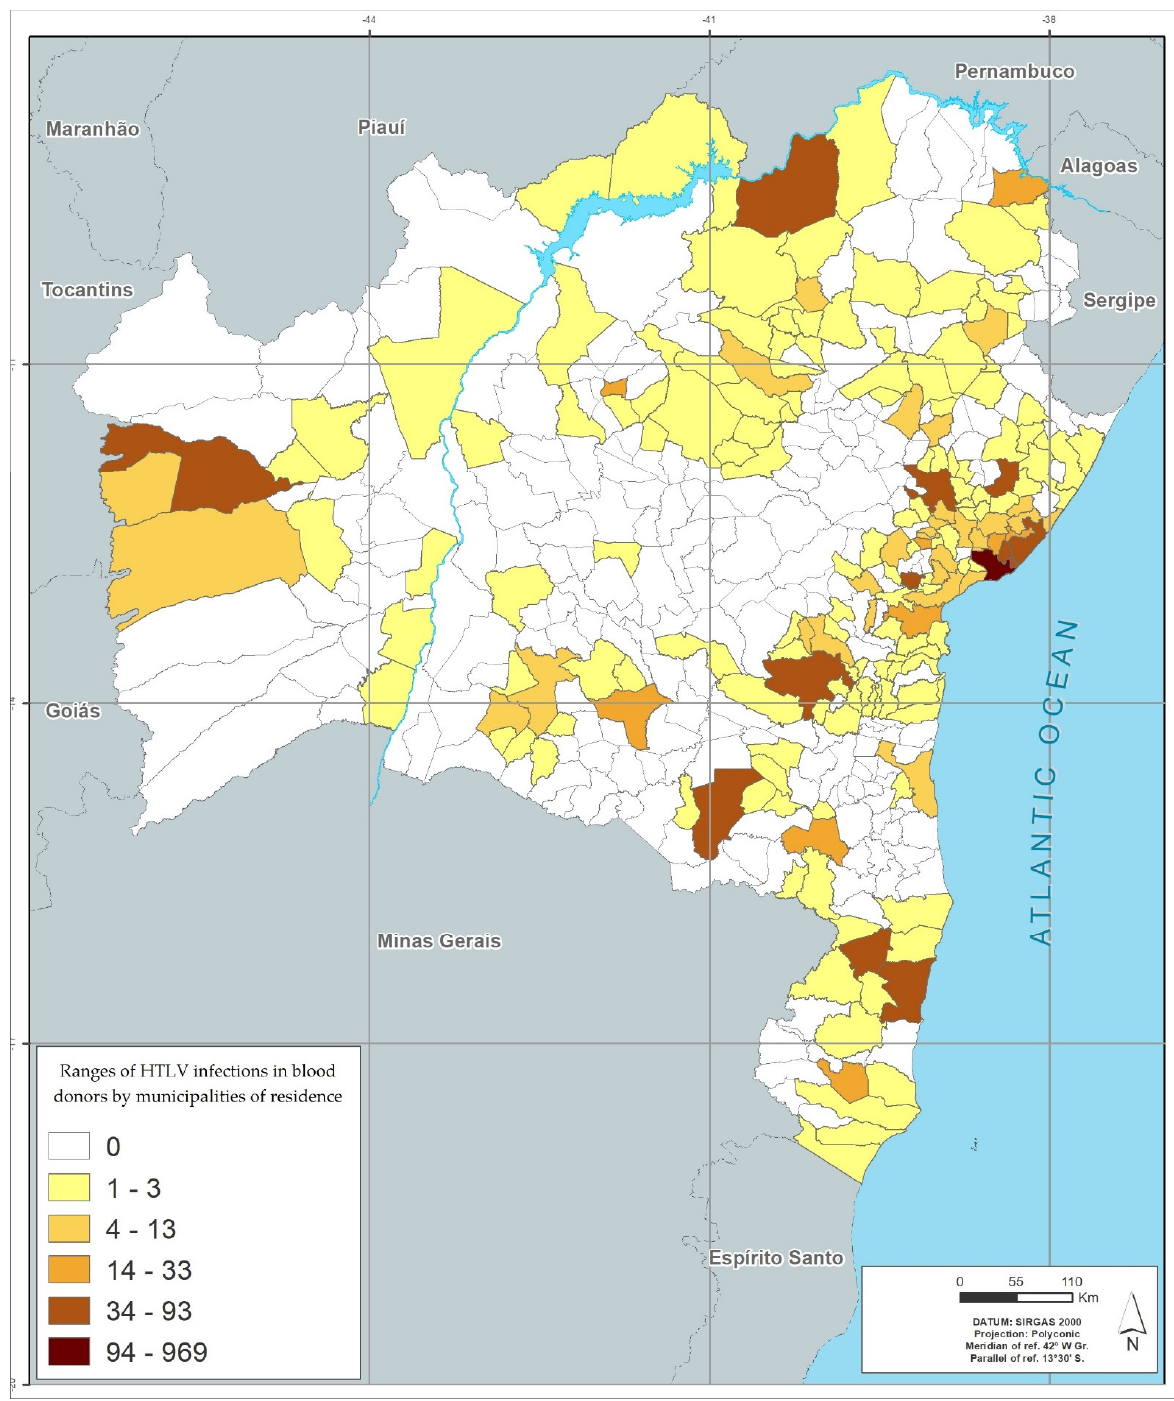
Figure 2. Infection’s rates in absolute numbers for HTLV by municipalities of residence in blood donors between 2008-2017.